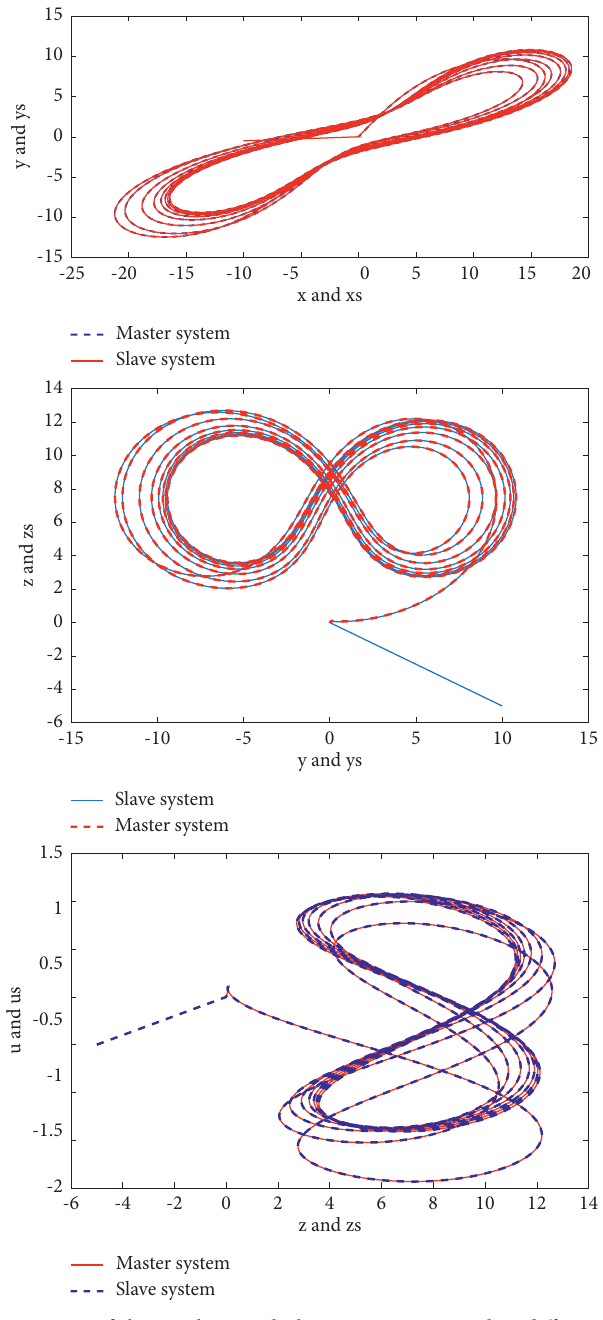
Figure 13: Some of the synchronized phase spaces projected to different